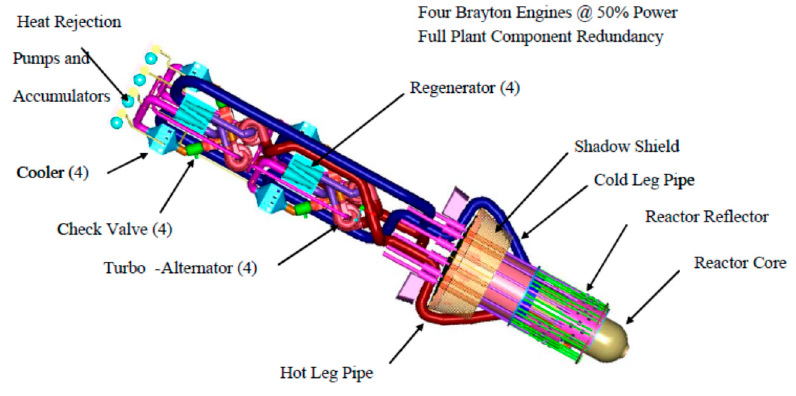
Figure 1. The Prometheus Project reactor module.